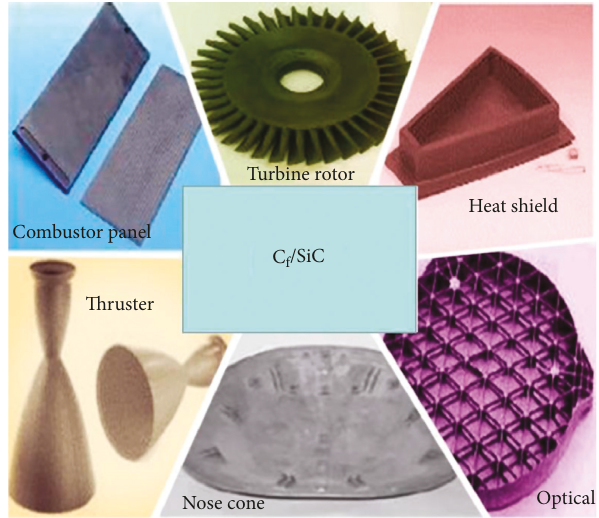
Figure 1: Various engineering applications of C